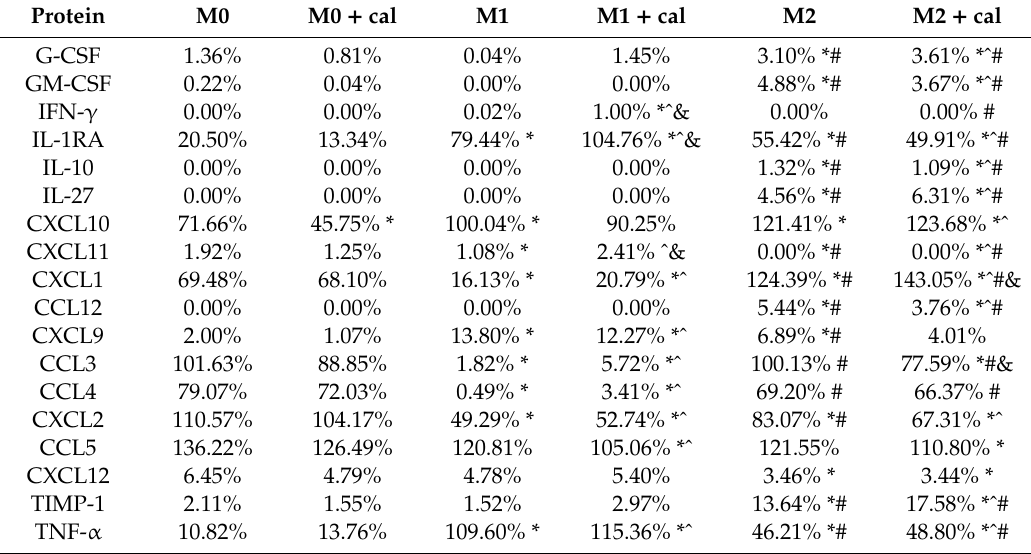
Table 1. Production of cytokines and chemokines in the cell culture supernatants of BMDMs polarized in the presence or absence of